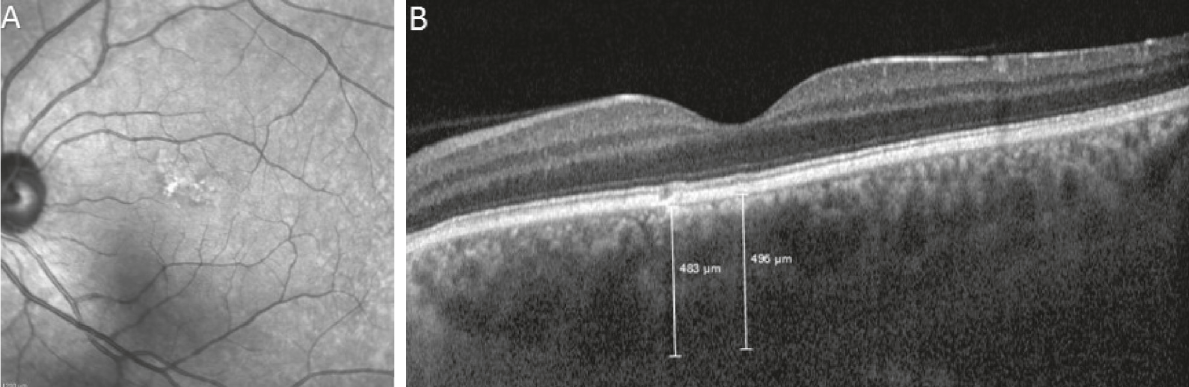
Figure 3: An infrared reflectance image (A) and enhanced depth imaging (EDI) mode of spectral domain optical coherence tomography (SD-OCT) image (B) of a 42-year-old male patient with coeliac disease. Irregular hyperreflectivity appears on the infrared reflectance image of the lesion. In the SD-OCTimage, pachyveins (enlargement of Haller’s layer) under the retinal pigment epithelium (RPE) change and thick choroid (subfoveal choroidal thickness: 496 μ m) is seen. Choroidal thickness is 483 μ m under the RPE changes. Table 2: The mean ± SD choroidal thickness measurements. Choroidal thickness